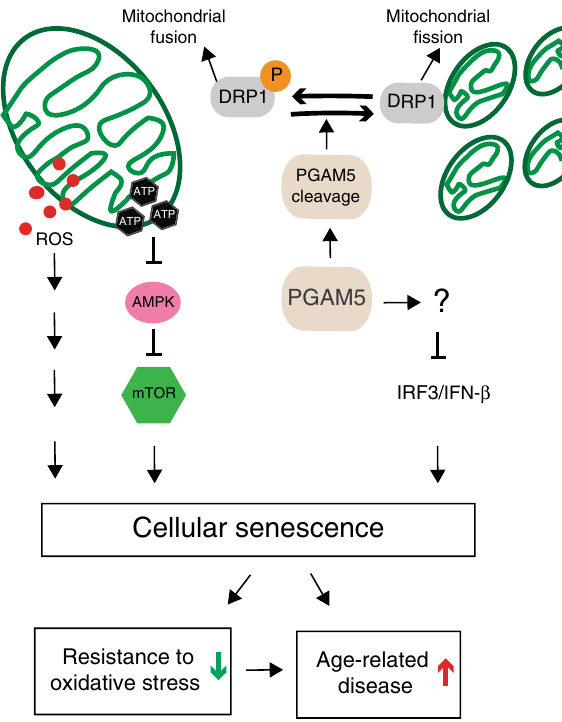
Fig. 10 Proposed model for PGAM5 in senescence. In this model, PGAM5 regulates senescence through several mechanisms. First, PGAM5 is required for regulating mitochondrial dynamics. PGAM5 deletion leads to elevation of Drp1 phosphorylation at Ser-637, which tip the balance of mitochondrial dynamics toward hyperfusion and less mitochondrial turnover. As result, this results in elevated ATP and ROS production, activation of AMPK – mTOR pathway, and accelerated senescence. Second, PGAM5 deletion promotes the IRF/IFN- β pathway, which could also contribute to cell senescence. PGAM5 deletion leads to resistance to oxidative stress, possibly through mitochondrial hyperfusion and/or upregulation of anti-oxidative genes. This resistance is lost in aging possibly due to the accelerated senescence caused by PGAM5 deletion. Our model highlights a critical role for PGAM5 in regulating mitochondrial dynamics, senescence and age-related oxidative